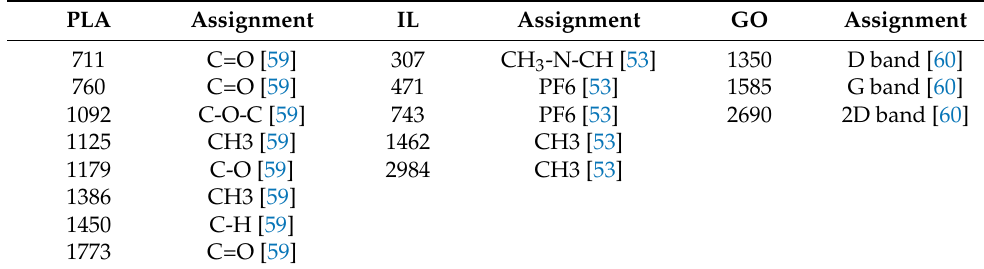
Figure 3. Raman spectra of PLA, PLP, PGO, and PGL ( a ); [Bmpyr]PF6 ( b ); and graphene oxide ( c ). Table 7. Raman frequencies in cm − 1 and